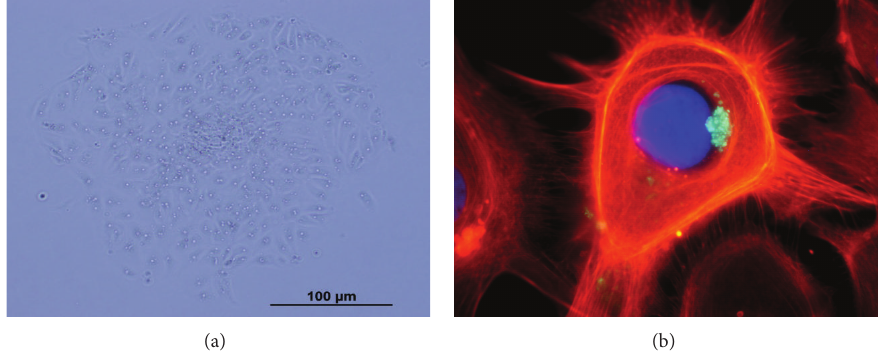
Figure 1: Normal human thyroid follicular cells in primary culture. (a) Thyrocytes in monolayers showing characteristic morphology by phase contrast microscopy and (b) immunocytochemistry of actin with phalloidin-fluorescein isothiocyanate (red), nuclei stained with DAPI (blue), and thyroperoxidase protein (green).